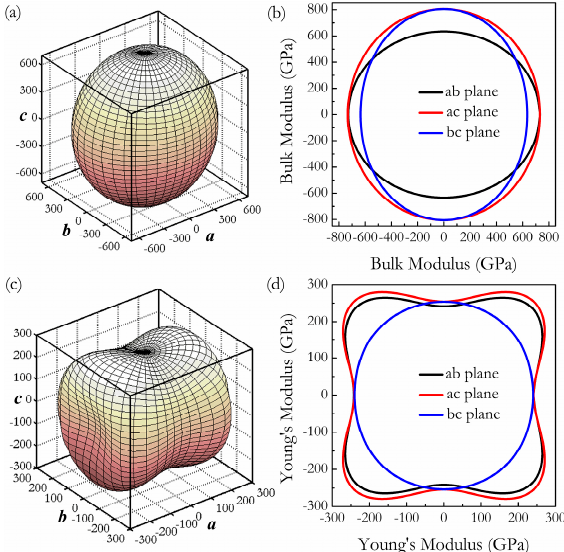
Figure 3. Three-dimensional surface representations of bulk modulus B ( a ) and the Young’s modulus E ( b ) at 0 GPa, and the projections of bulk modulus B ( c ) and the Young’s modulus E ( d ) within ab , ac , and bc planes.